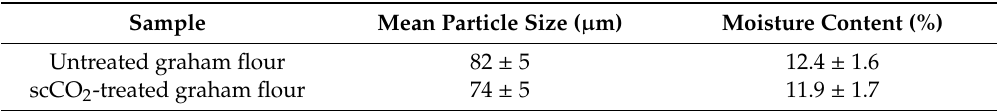
Table 1. Comparison of the particle size distribution of the graham flour and the moisture content as a function of scCO 2 treatment.